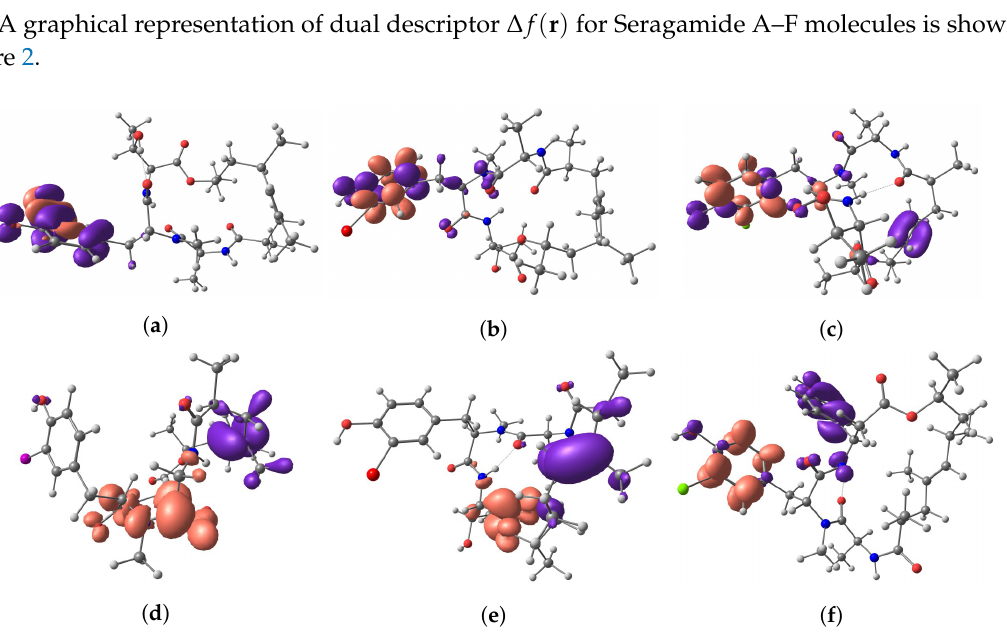
Figure 2. Graphical sketches of the Dual Descriptor ∆ f ( r ) of: ( a ) Seragamide A; ( b ) Seragamide B; ( c ) Seragamide C; ( d ) Seragamide D; ( e ) Seragamide E; and ( f ) Seragamide